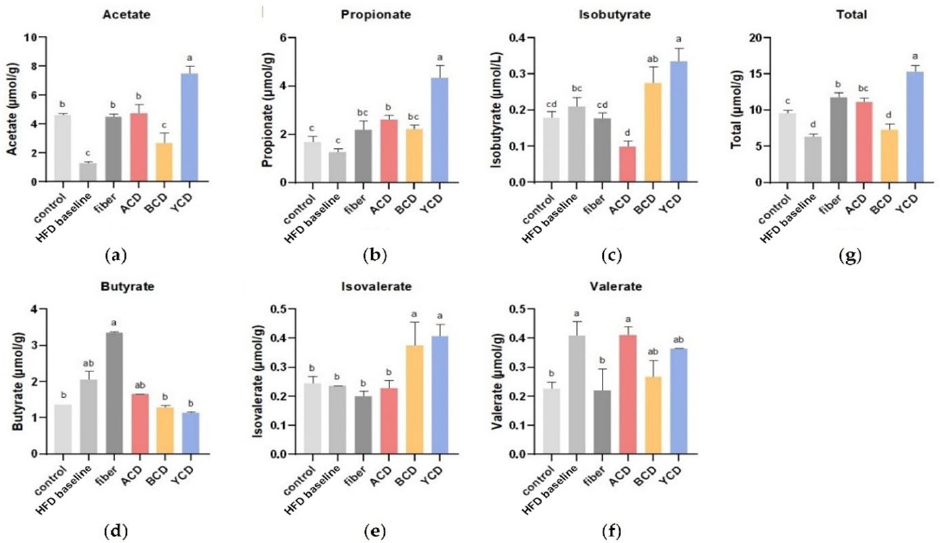
Figure 6. α -CD and γ -CD supplementation enhanced SCFA levels of cecum contents. Concentrations of ( a ) acetate; ( b ) propionate; ( c ) isobutyrate; ( d ) butyrate; ( e ) isovalerate; ( f ) valerate; and ( g ) total SCFAs in cecum contents. n = 6. Control, low-fat diet; HFD baseline, high-fat diet without cellulose; fiber, high-fat diet; ACD, high-fat diet that replaced α -CD with cellulose; BCD, high-fat diet that replaced β -CD with cellulose; YCD, high-fat diet that replaced γ -CD with cellulose. Data are expressed as means ± SEM. Values not sharing a common superscript differ significantly among groups ( p < 0.05, ANOVA).